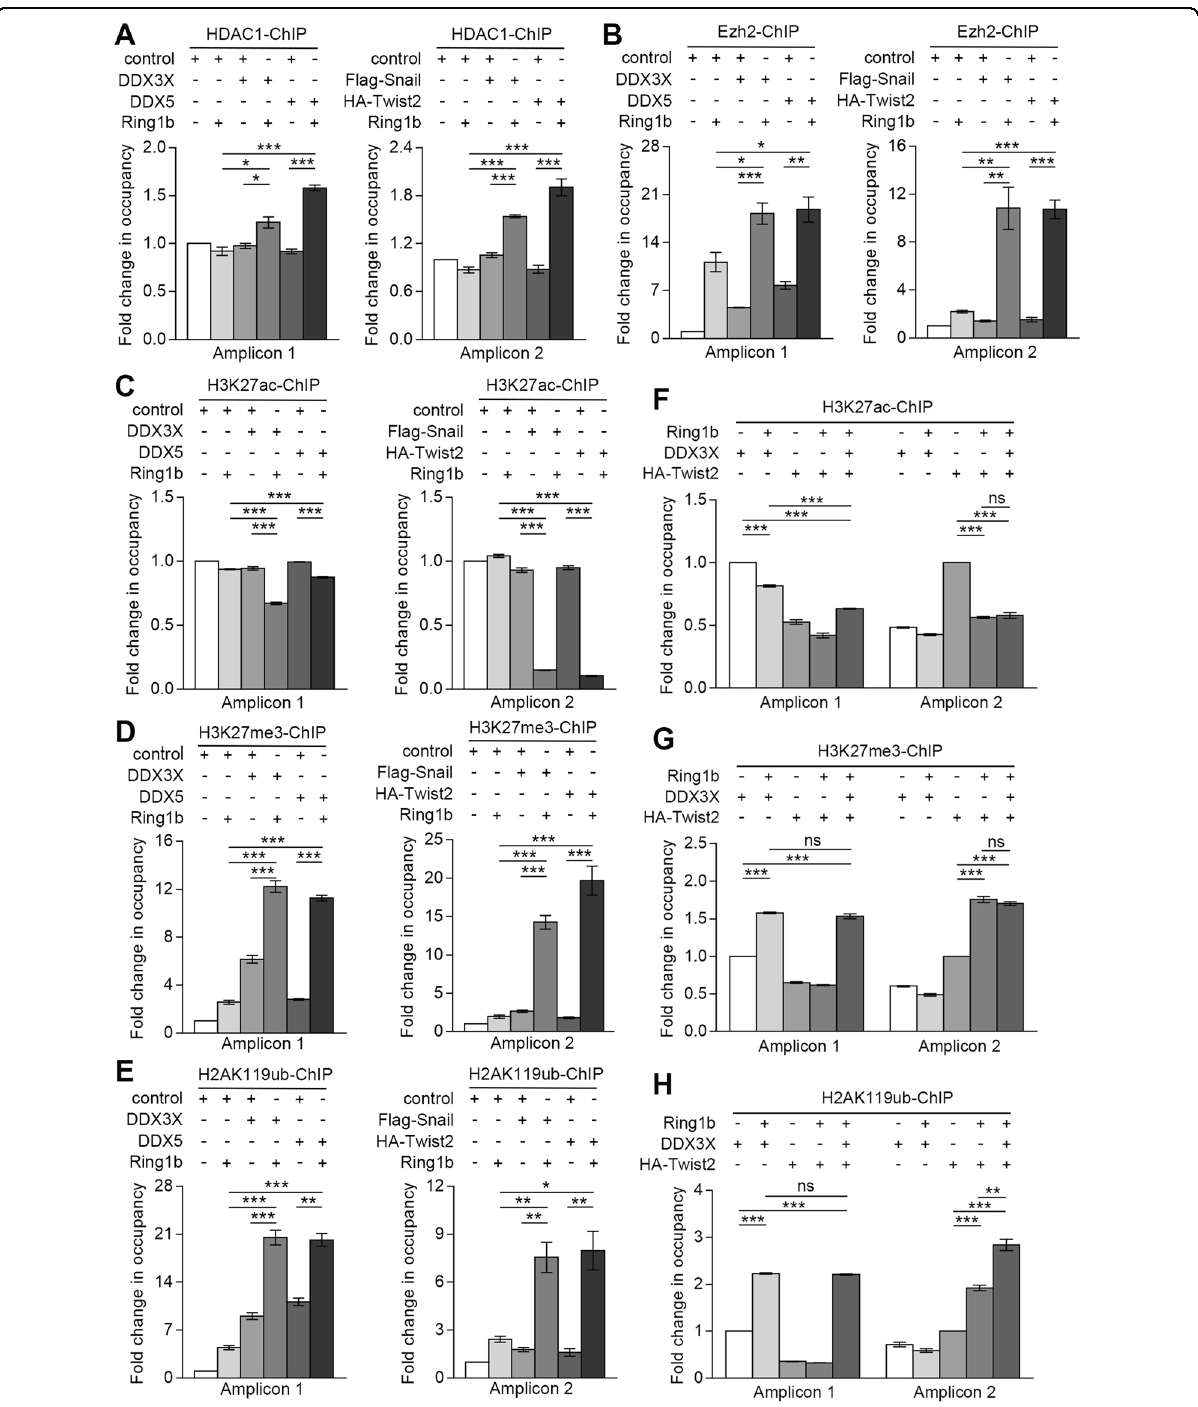
Fig. 6 Ring1b-dependent epigenetic remodeling is associated with multiple epigenetic markers. Proteins as indicated were stably overexpressed or knocked down in 10 A cells using lentivirus. IgG was used as control antibody. Immunoprecipitated DNA fragments were captured by antibodies as indicated. The probability of proteins binding to E-cadherin promoter was analyzed by ChIP-qRT-PCR. A, B Effect of HDAC1 and Ezh2 on E-cadherin transcription. C – E Effect of Ring1b complexes on epigenetic markers distribution on the E-cadherin promoter. F – H Effect of three proteins on epigenetic markers distribution on the E-cadherin promoter. Error bars represent the means ± SEM. Unpaired t -test is performed to indicate a statistically signi fi cant difference. ns, P ≥ 0.05; * P < 0.05; ** P < 0.01; *** P <